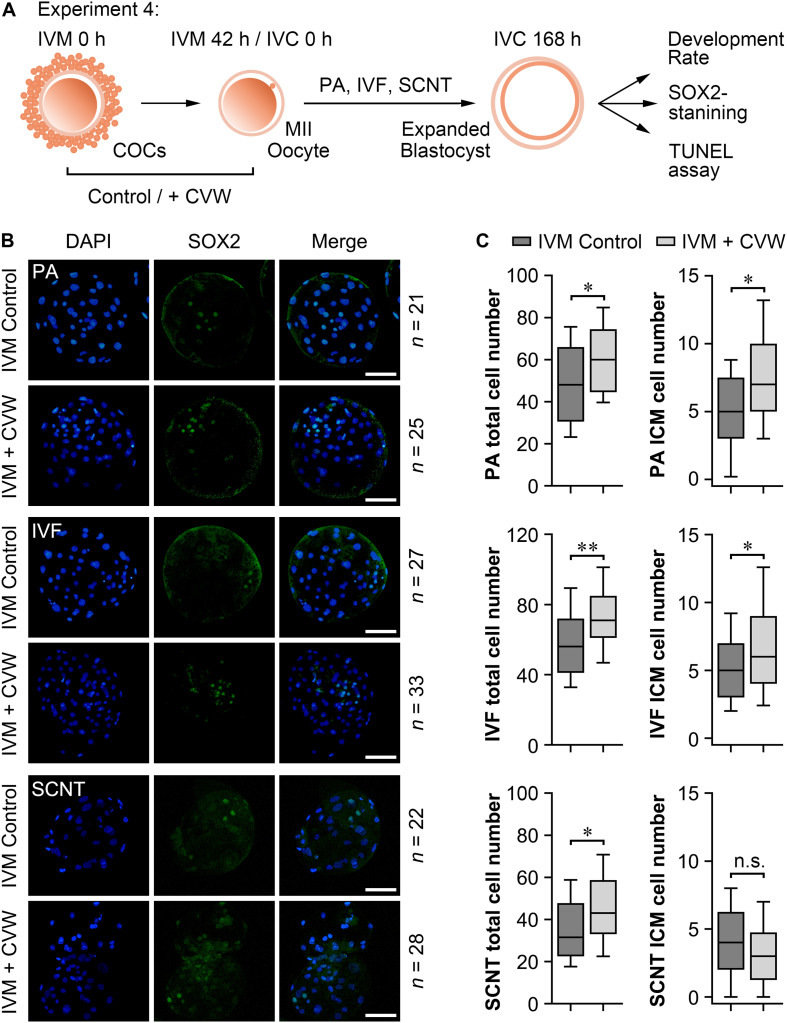
Cell numbers in blastocysts derived from oocytes matured with or without CVW supplementation. (A) Experimental design to determine the development rate and blastocyst quality. (B) Immunostaining of SOX2 (green) and DAPI (blue) in PA, IVF and SCNT blastocysts derived from control and CVW-treated oocytes. Scale bar = 100 μm. (C) Box plots show the total cell numbers and inner cell mass (ICM) cell numbers of PA, IVF and SCNT blastocysts derived from control and CVW-treated oocytes. All middle lines in box plots indicate the median, the edges indicate the 25th/75th percentiles and the whiskers indicate the 10th/90th percentiles. n.s, not significant. ∗P < 0.05, ∗∗P < 0.01 (Student’s t-test).